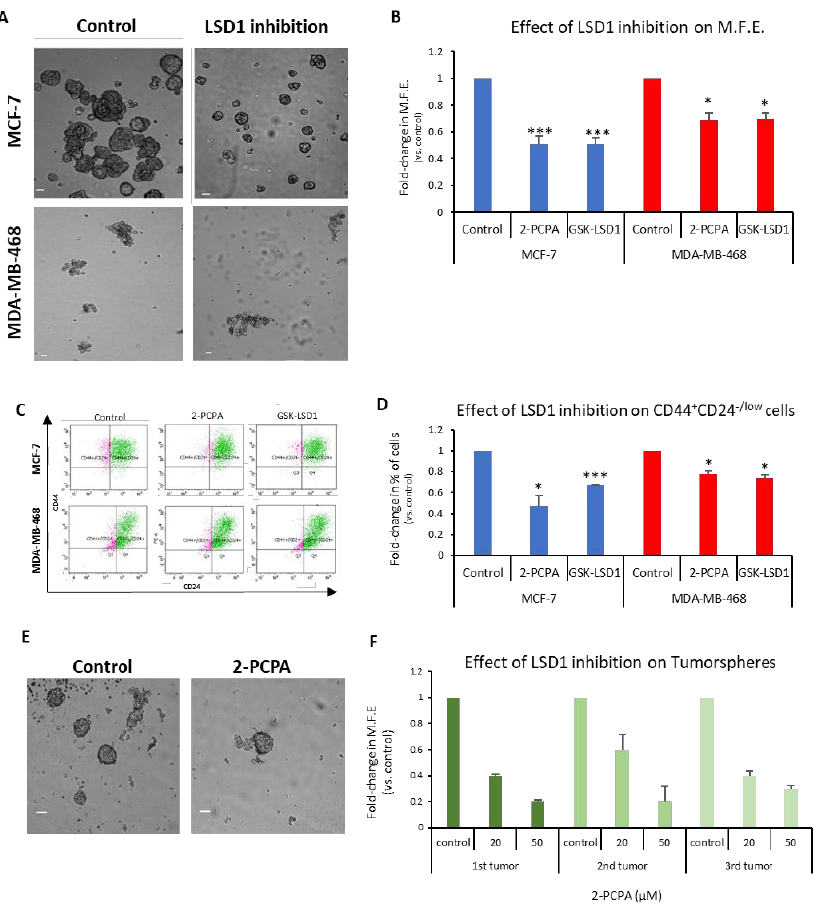
Figure 4. Pharmacological inhibition of LSD1 a ff ects the stemness properties of bCSCs. ( A ) Representative images of MCF-7 and MDA-MB-468 mammospheres after inhibition of LSD1 with 2-PCPA (50 µ M) for 7 days. Vehicle-treated spheres served as the control. ( B ) Graphical representation of the e ff ects of LSD1 inhibition on the MFE MCF-7 and MDA-MB-468 mammosphere-derived single cells. The cells were treated with 2-PCPA (50 µ M) or GSK-LSD1 (2 µ M) for 7 days and, on the last day, the number of formed mammospheres was counted and the MFE was calculated. ( C ) FACS analysis for the CD44 and CD24 cell surface markers was performed for the mammosphere-derived single cells after inhibitor treatment. Vehicle-treated cells were used as control. ( D ) Quantification of FACS analysis data presented in ( C ). ( E ) Representative images of patient tumorspheres after treatment with vehicle (control) or 2-PCPA (50 µ M) for 7 days. ( F ) Graphical representation of the e ff ects of LSD1 inhibition on the MFE of patient tumorspheres. Patient tumorsphere-derived single cells were cultured, under mammosphere-forming conditions, in the presence of 2-PCPA (20 or 50 µ M) for 7 days. On the last day of treatment, the number of tumorspheres was counted and the MFE was calculated. Error bars represent SEM. * p < 0.05, *** p < 0.001. In ( F ), error bars represent the SEM of technical replicates ( n = 3–4). Scale bars represent 50 µm.